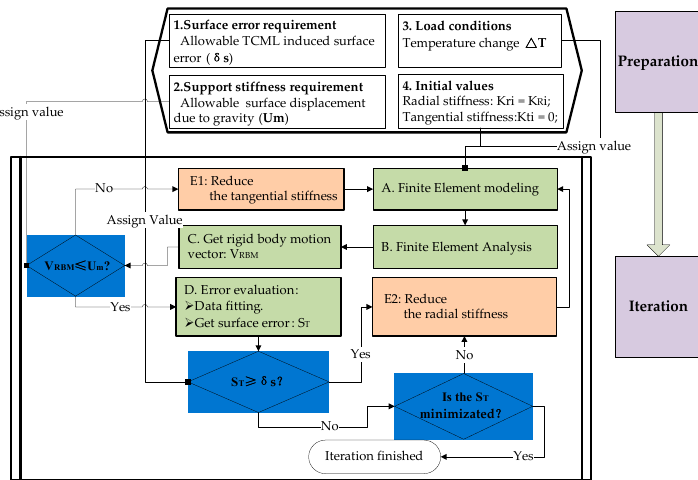
Figure 7. Flowchart of the optimization of the stiffness